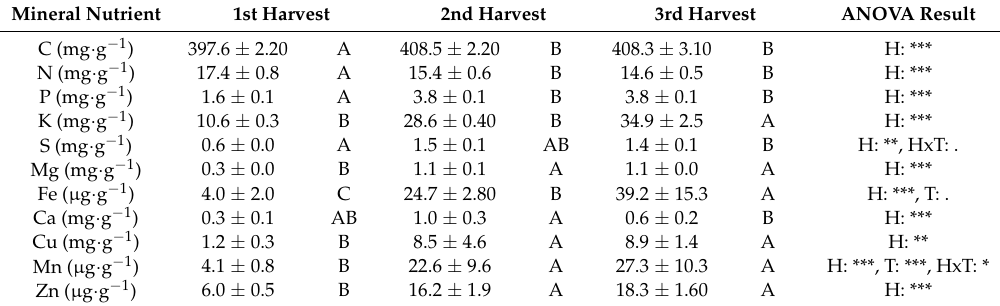
Table 4. Average fruit mineral concentrations ( ± SD) shown for the three harvests and the corresponding ANOVA results. Different letters indicate significant differences (Tukey’s HSD, n = 3, p < 0.05) for harvests. The factors, harvest (H) and treatment (T), and their interaction (H*T) were reported by “***” for p < 0.001, “**” for p < 0.01, “*” for p < 0.05 and “.” for p < 0.1.